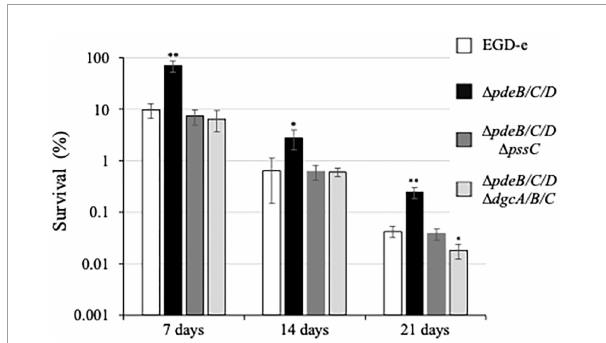
FIGURE5 Survival under desiccation of the L. monocytogenes biofilms. The 48-h old biofilms formed on cantaloupe coupons containing rind and pulp (diameter, 20 mm; depth 4 mm) were placed in Petri dishes rind up and allowed to dry on open air. A coupon was cut into four quarters. One quarter was used for enumeration of initial CFUs, other quarters were subjected to desiccation and withdrawn on days 7, 14, and 21 days, respectively. Following withdrawal, the coupon quarters were rehydrated, homogenized, and subjected to CFU enumeration. For each strain, survival was calculated based on the initial CFU number of that strain on day 0 (assigned to 100%). Prior to the experiment, ∼ 90% of the biofilm biomass of the EPS-synthesizing strain, (cid:49) pdeB/C/D , was removed from rind to bring the initial CFU numbers close to those of other strains. The average initial CFUs per coupon quarter for all strains were within the range of (1.1–3.4) × 10 8 . Significant differences, compared to EGD-e, are indicated as follows: ∗ P < 0.05 and ∗∗ P < 0.01.